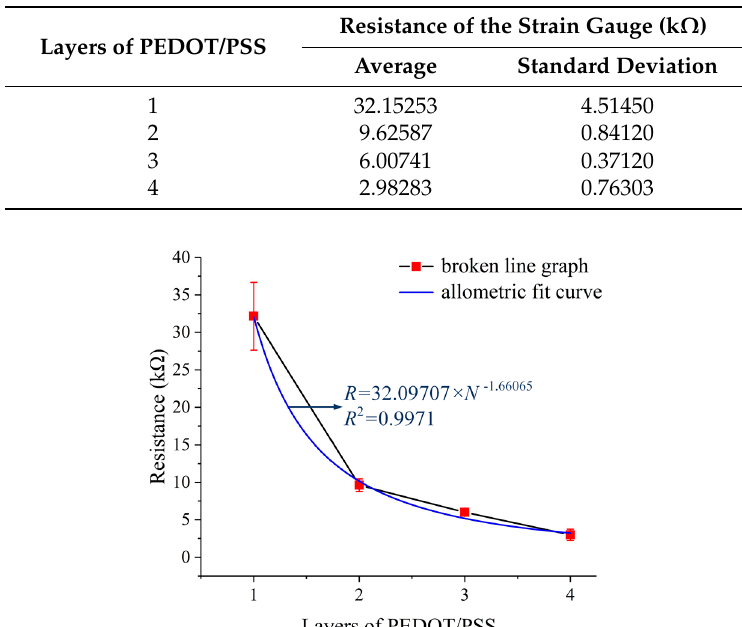
Table 3. The average values and standard deviations of the resistance.